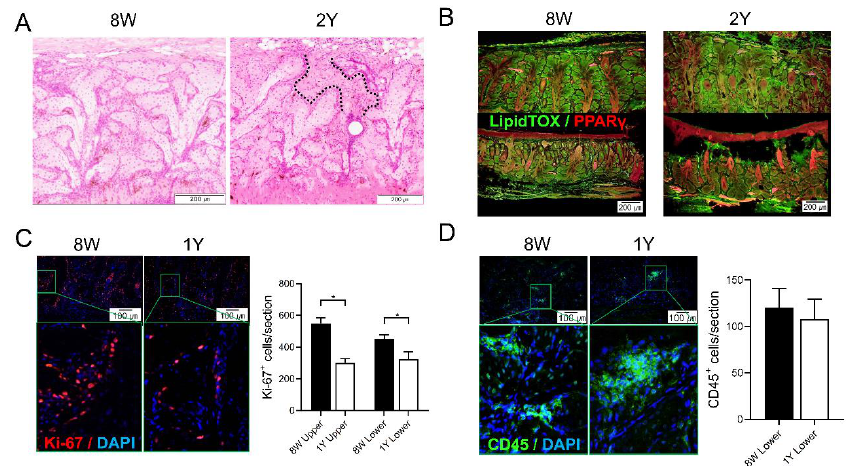
Figure 3. ( A ) Representative images of coronal sections of the MGs stained with hematoxylin-eosin (H&E). The area between the dotted lines indicates suspicious MG dropout (200×). ( B ) Representative images of coronal sections of the MGs stained with LipidTOX and PPARγ immunofluorescence (100×). ( C ) The expression of Ki67 + cells in both MGs of the upper and lower eyelids was significantly reduced in 1Y-old mice compared to 8W-old mice ( p = 0.036 by the Mann–Whitney test and 0.035 by the independent t-test, respectively; 200×). ( D ) The expression of CD45 + cells in the MGs of the lower eyelid was not different between 8W- and 1Y-old mice ( p = 0.571; Mann–Whitney test; 200×). All images were obtained from the coronal section. n = 5 and 3 for 8W- and 1Y-old mice, respectively. * p < 0.05. Int. J. Mol. Sci. 2020 , 21 , x FOR PEER REVIEW